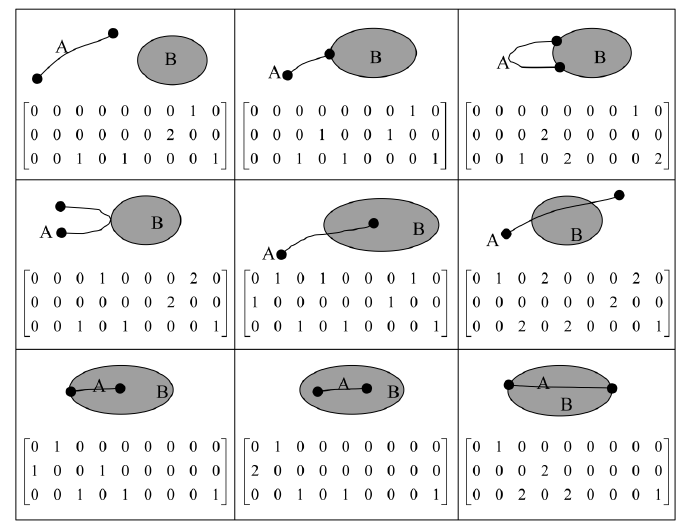
Figure 7. The formalism of the 27IM and the corresponding geometric interpretations between a line and a region.